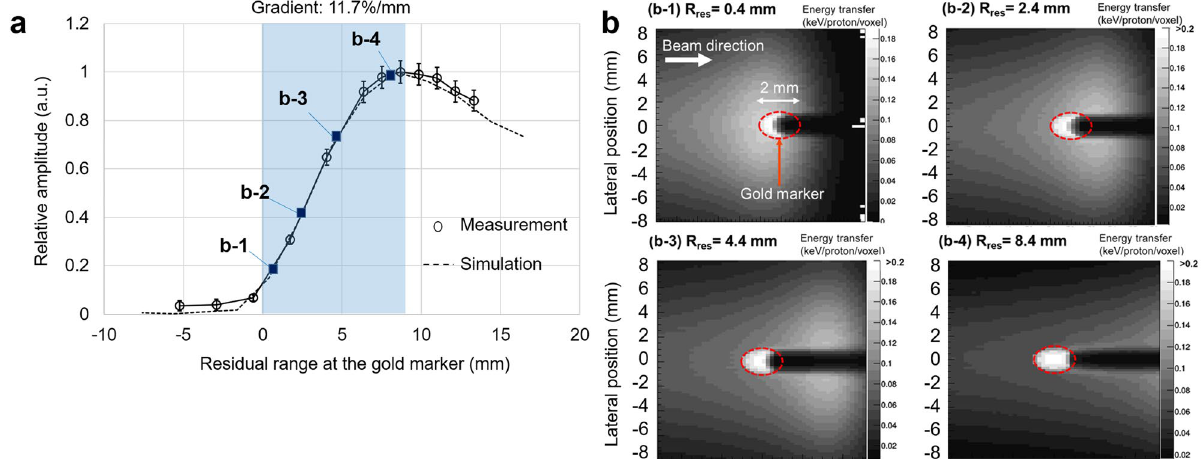
Figure 4. Variation in SPIRE amplitude with the residual range at the marker position. (a) The SPIRE amplitude, defined as the amplitude at the peak frequency (1.53 MHz), as measured for different values of the residual range at the marker by stacking the acrylic plates in front of the water phantom. (b) For each residual range ( R res of 0.4, 2.4, 4.4, and 8.4 mm), the calculated energy distributions in and nearby the gold marker are shown in (b-1)–(b-4), respectively. As shown in (a), the measurement results agree well with the results of the simulation after the application of a systematic correction of 0.8 mm to the measured residual range. The peak frequency for the simulation was 1.62 MHz. A sharp increase in the SPIRE amplitude (11.7%/mm) was observed for 0 mm < R res < 9 mm (the region shaded in blue), which reflects the strong variation in the size of the energy deposition in the marker around the Bragg peak (shown in (b)). Given the relatively small SD of the signal, the beam range can be estimated with submillimetre accuracy as long as this experimental setup is